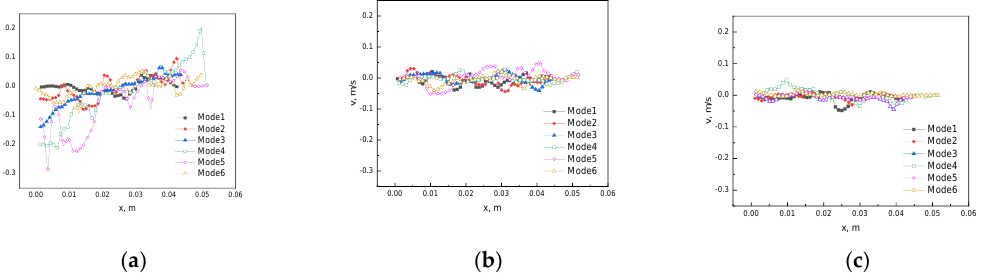
Figure 6. Horizontal component of velocity at 1 mm below liquid surface in three physical forms of hydraulic jump (casting speed 0.8 m/min). ( a ) CHJ; ( b ) HJT; ( c ) SLL.